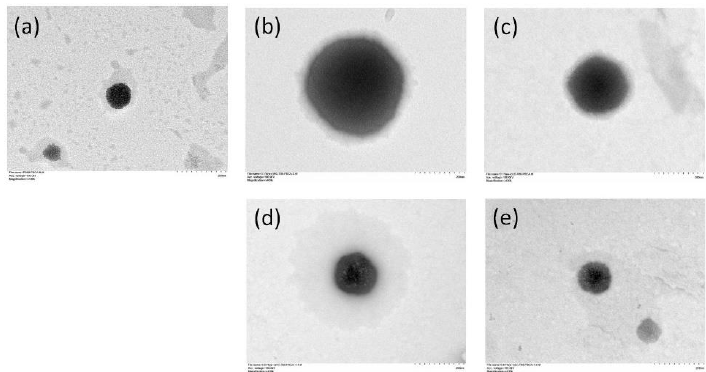
Figure 4. TEM micrographs of ( a ) PS80 PBCA NP, ( b ) 0.1% ( w / v ) HMWC-PS80 PBCA NP, ( c ) 0.1% ( w / v ) LMWC-PS80 PBCA NP, ( d ) 0.01% ( w / v ) HMWC-PS80 PBCA NP, and ( e ) 0.01% ( w / v ) LMWC-